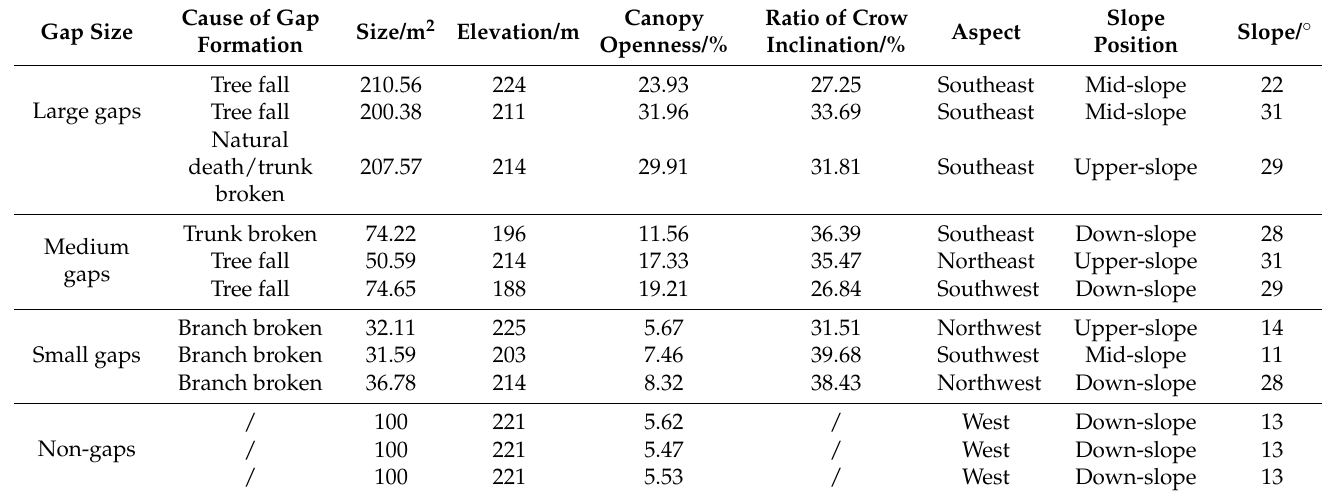
Table A1. General information on canopy gaps and non-gaps in the natural forest of C. kawakamii .